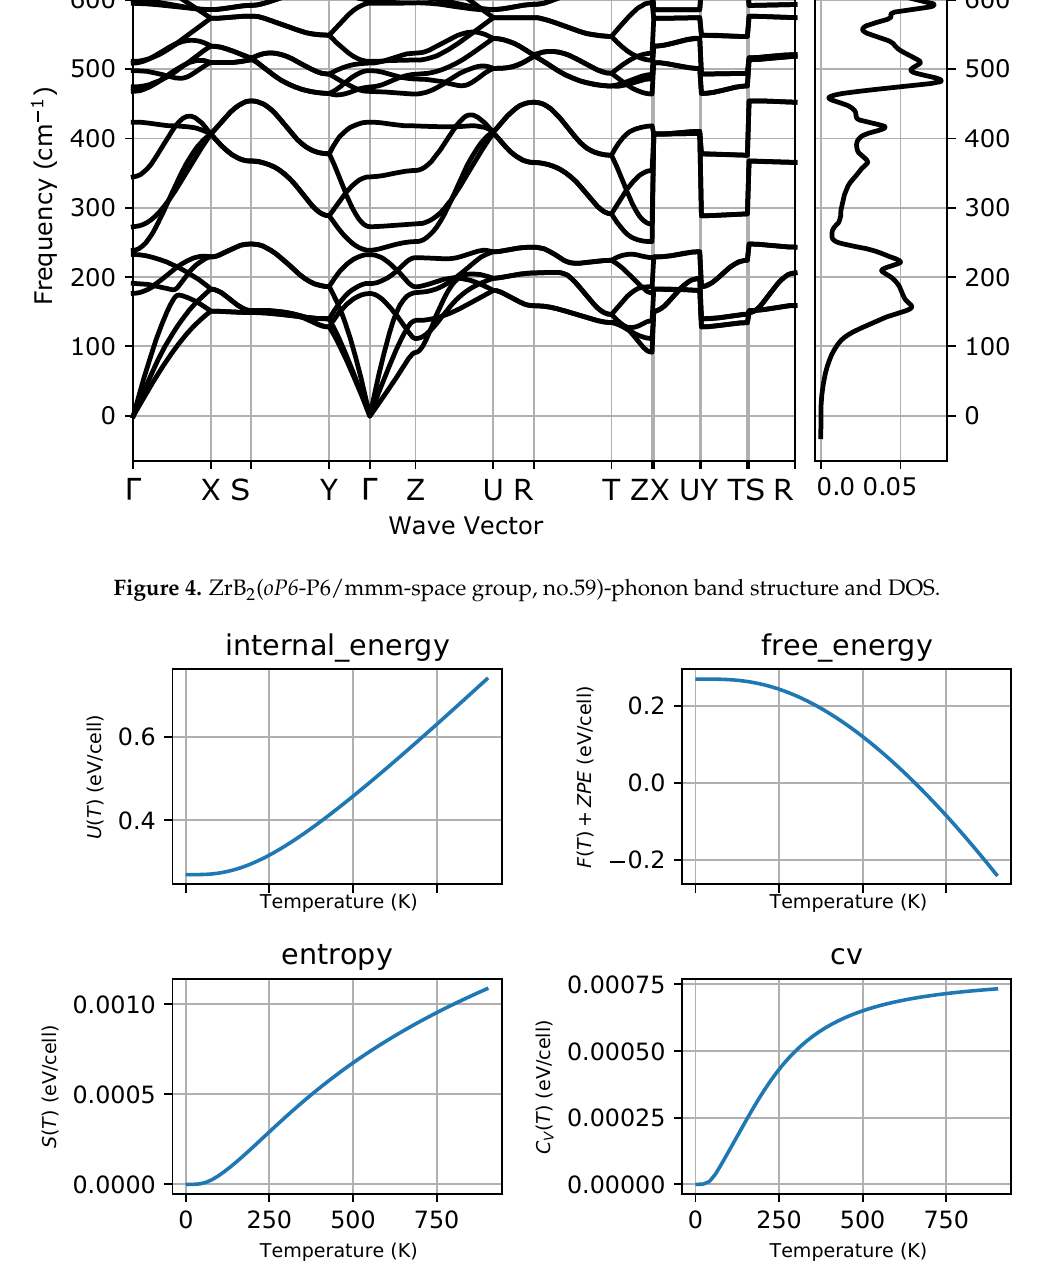
Figure 5. ZrB 2 ( hP3 -P6/mmm-space group, no. 191)-thermodynamic properties: internal energy, free energy, entropy and constant-volume specific